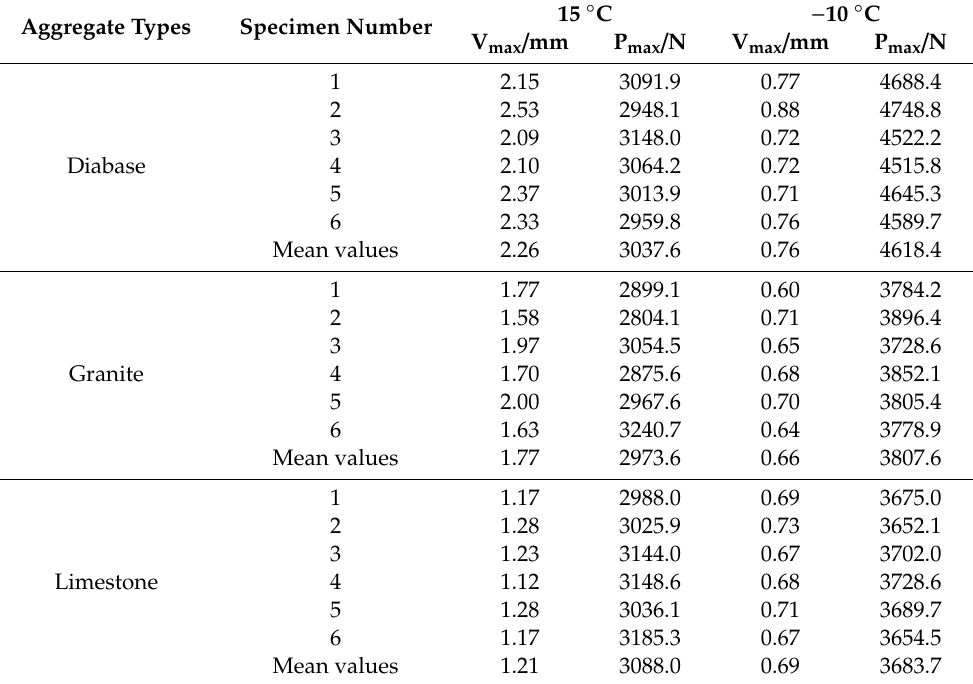
Table 10. Three-point bending test results for EACs with the three types of aggregates.